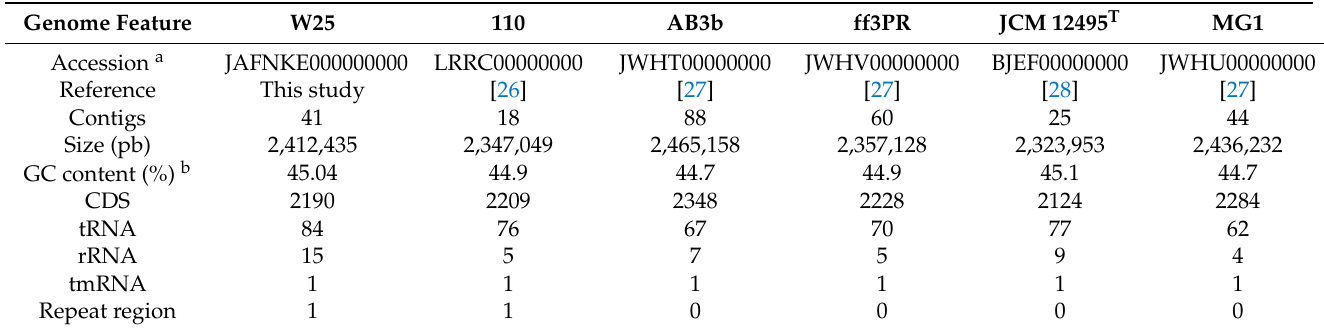
Table 1. Comparison of the genomic feature of W. cibaria W25 with a bacteriocin-producing W. cibaria , strains 110, and four other non-bacteriocin-producing